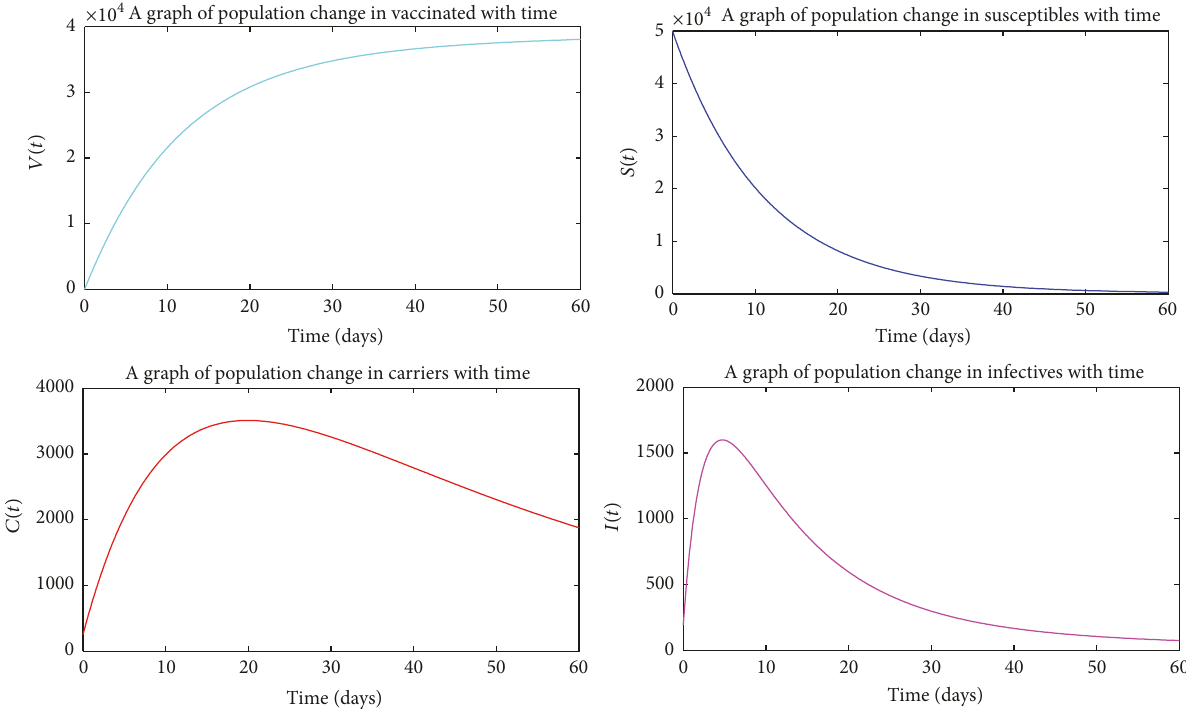
Figure 4: Variation of the population under treatment and vaccination